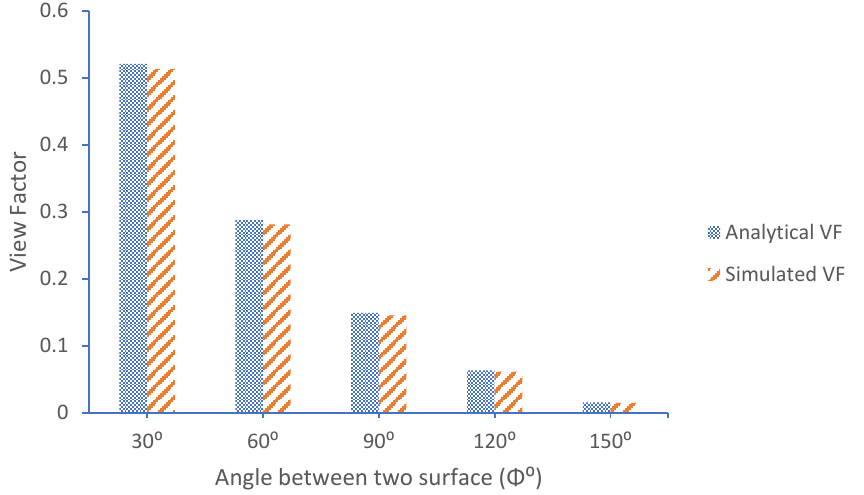
Figure 5. View factor at different angles between surfaces for a = 2 m, b = 1 m, and c = 1 m, and h i = 0.01 m. Table 2 . View factor simulation parameters for element size h i = 0.01 m and number of iterations = 4.0E+08.